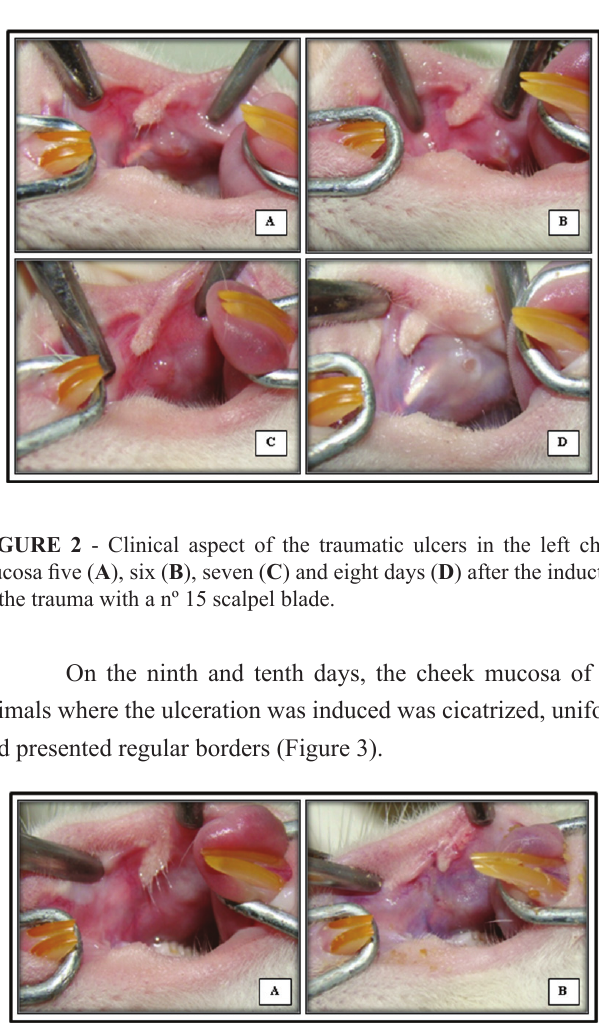
FIGURE 3 - Clinical aspect of the traumatic ulcers in the left cheek mucosa nine ( A ) and ten days ( B ) after the induction of the trauma with a nº 15 scalpel blade.